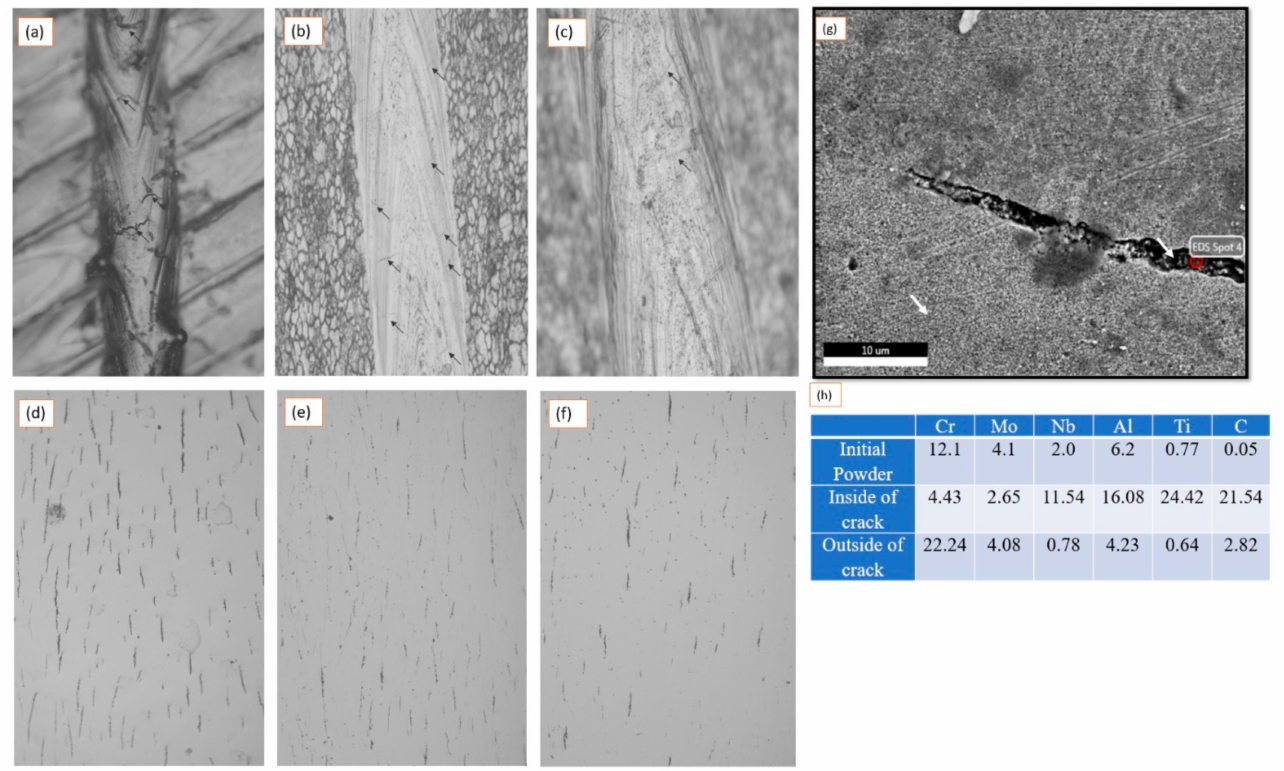
Figure 5. OM images of ground and polished IN713LC samples ( a ) single track made by energy input 360 J/m; ( b ) single track made by energy input 280 J/m; ( c ) single track made by energy input 210 J/m; ( d ) bulk cubic sample made by energy input 360 J/m; ( e ) bulk cubic sample made by energy input 280 J/m; ( f ) bulk cubic sample made by energy input 210 J/m; ( g ) points selected for EDS analysis in in IN713LC sample fabricated using energy density of 360 J/m; ( h ) alloying element concentrations inside and outside of the